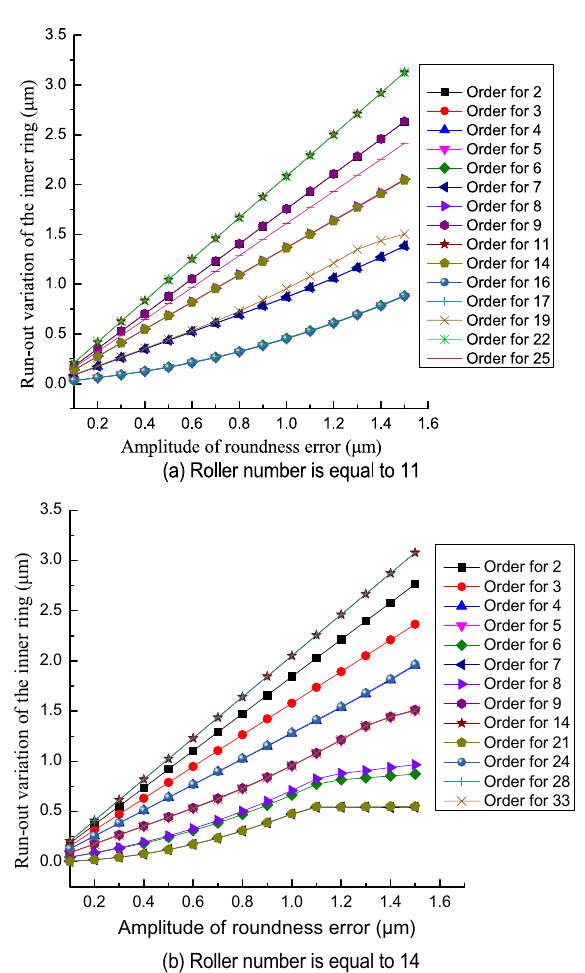
(b) Roller number is equal to 14 Figure 10. Effect of the amplitude of the roundness error in the inner raceway on the run-out variation of the inner